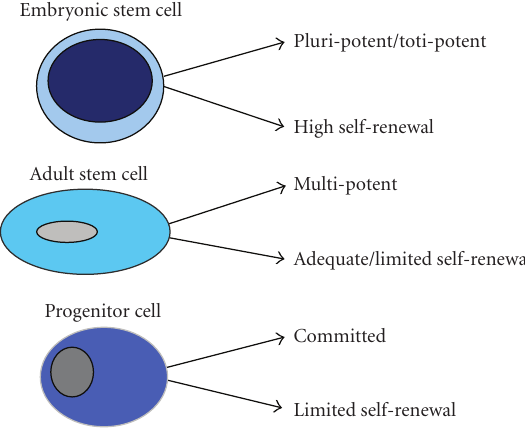
Figure 1: Di ff erentiation and self-renewal potential of embryonic stem cells, adult stem cells, and progenitor